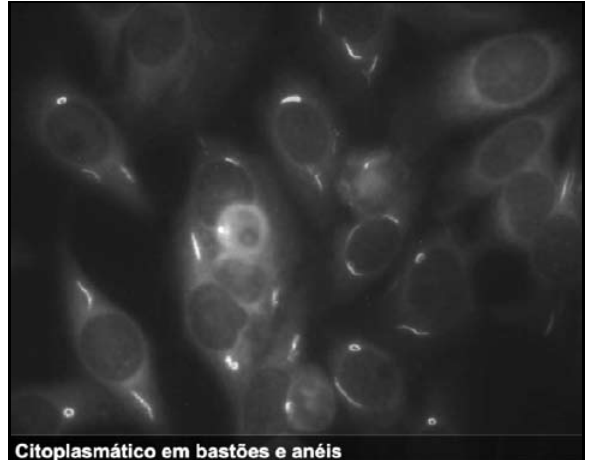
Figura 4 – Padrão citoplasmático com fluorescência em forma de bastões e anéis (rods and rings) . Aparentemente associado à infecção pelo HCV e tratamento com